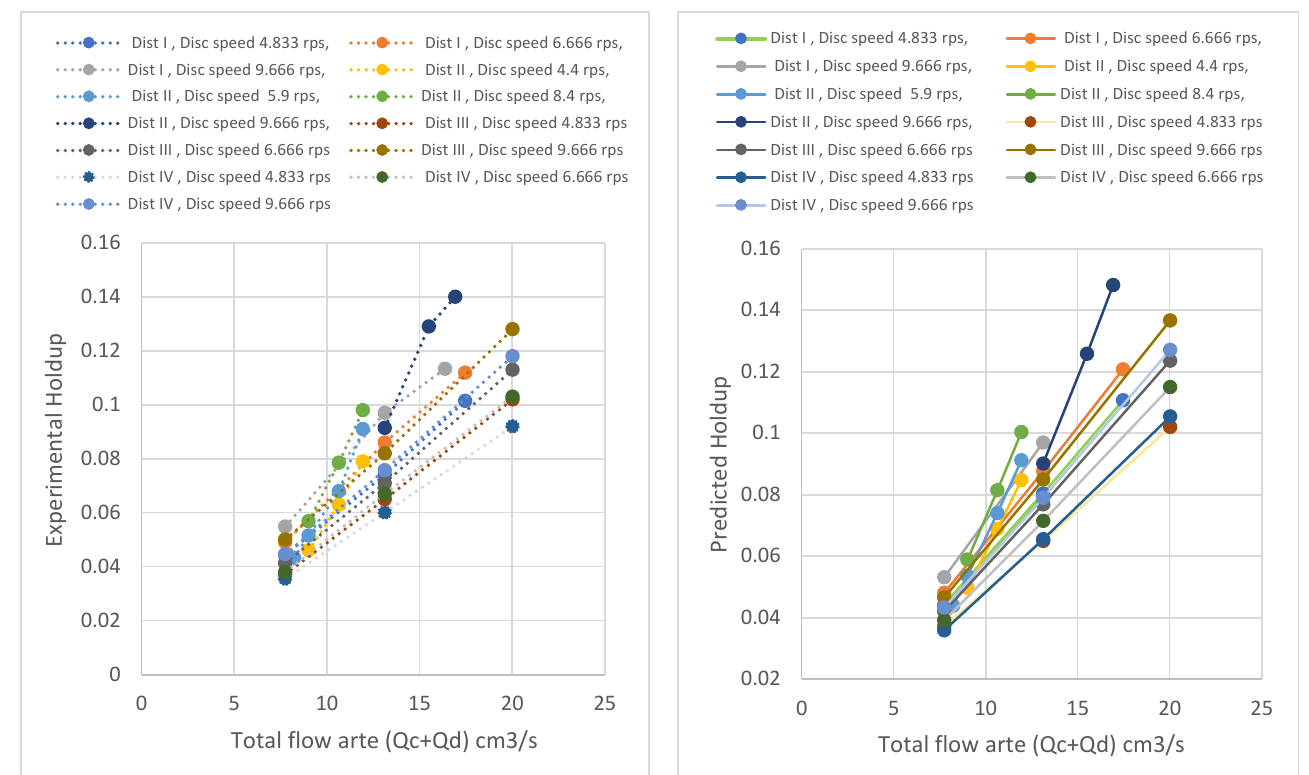
Figure 3. Dispersed phase holdup versus total flow rate, for the values experimentally measured and the theoretically predicted, for all distributors.